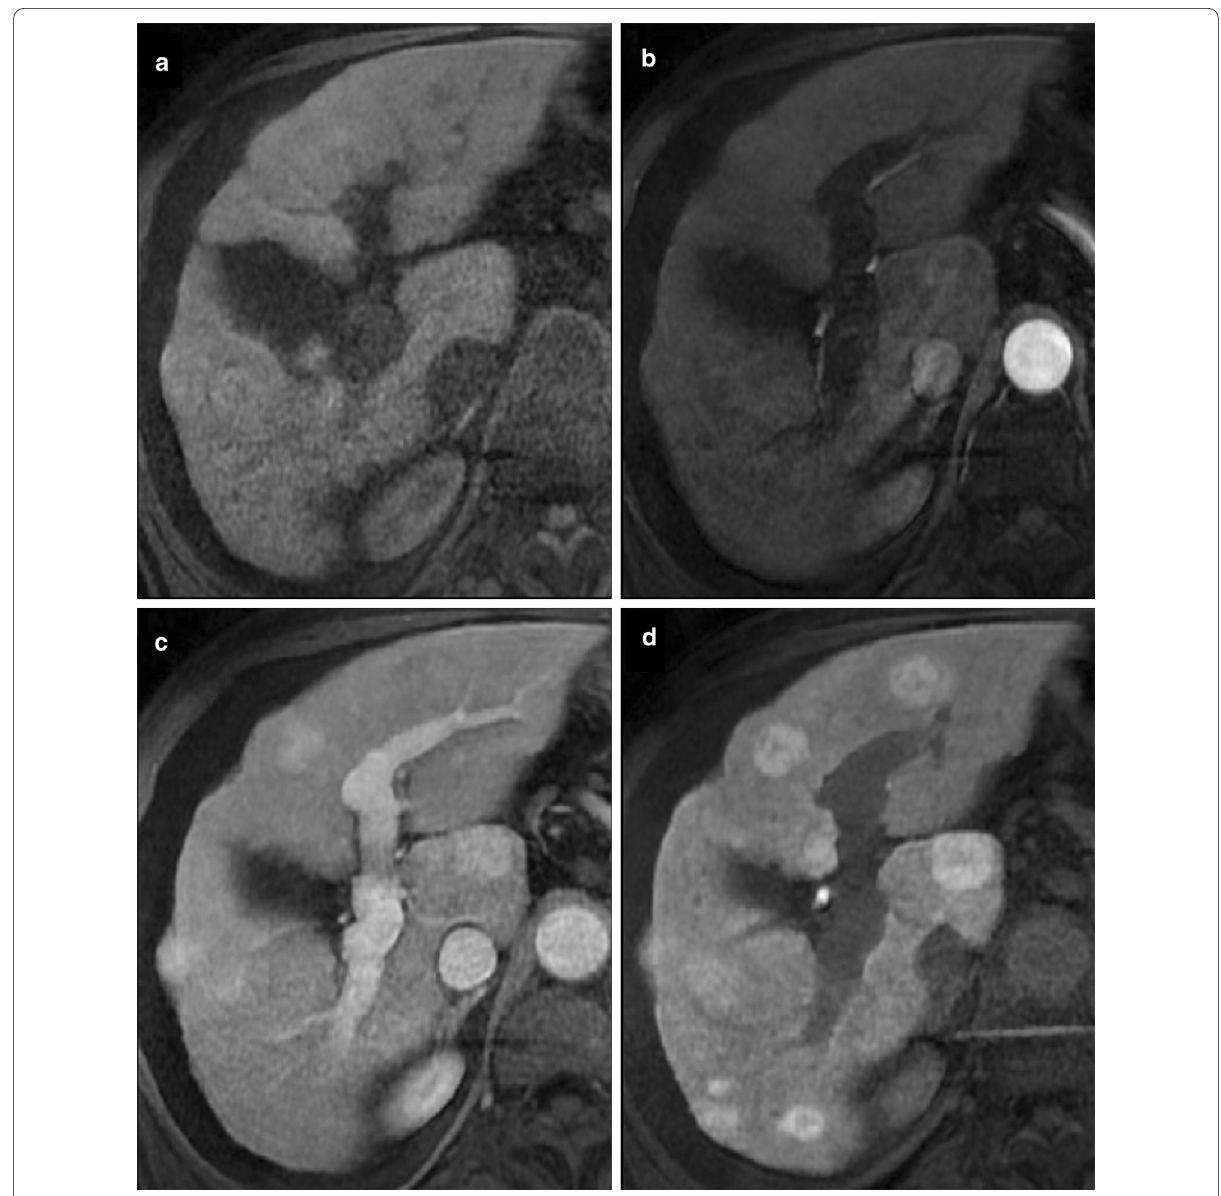
Fig. 16 A 71‑year‑old man with HCV‑related cirrhosis and multiacinar cirrhotic nodules. Gadoxetate disodium‑enhanced MR shows multiple multiacinar cirrhotic nodules that are ( a ) isointense to surrounding liver parenchyma in the precontrast T1‑weighted sequence and ( b ) in the hepatic arterial phase, ( c ) show enhancement in the portal venous phase due to early uptake of hepatobiliary contrast and ( d ) are hyperintense in the hepatobiliary